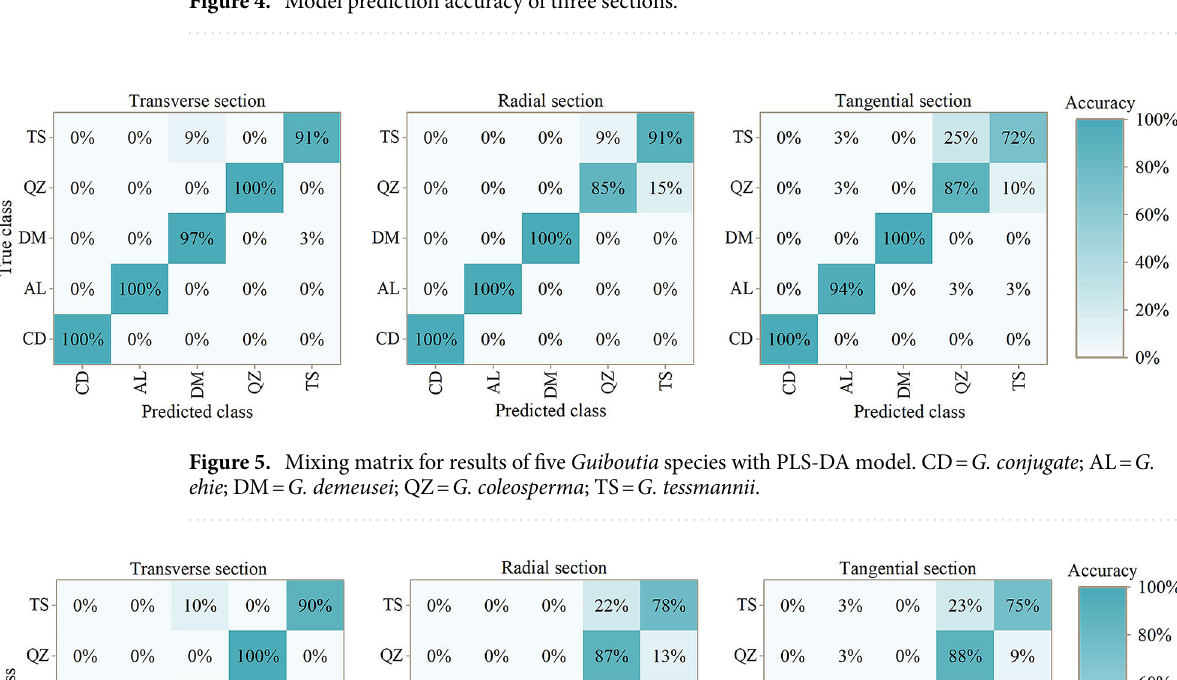
Figure 4. Model prediction accuracy of three sections.